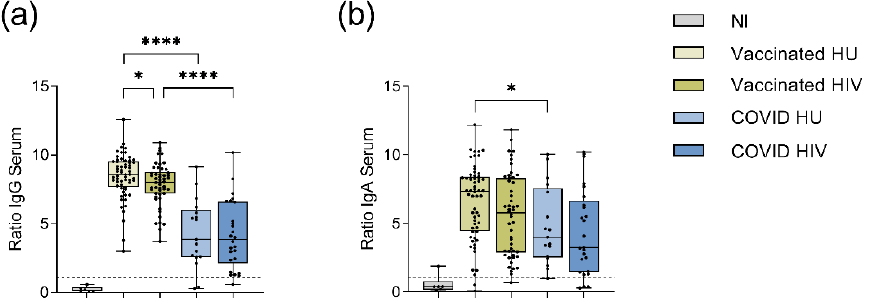
Figure 1. Spike-specific IgG and IgA antibodies in the serum of vaccinated and COVID-19 conva- lescent subjects as measured by ELISA. The IgG and IgA levels are presented as ratios obtained by dividing the extinction of the sample by that of the assay calibrator. ( a ) Spike-specific IgG and ( b ) Spike-specific IgA in the serum of BNT162b2 mRNA vaccinated ( n = 110) and COVID-19 con- valescent ( n = 43) subjects. Medians and interquartile ranges (IQRs) are presented for SARS-CoV-2 non-immune (NI, n = 6), vaccinated HIV-1-uninfected (HU, n = 60), vaccinated HIV-1-infected (HIV, n = 50), COVID-19 convalescent HIV-1-uninfected (COVID HU, n = 17) and COVID-19 convalescent HIV-1-infected (COVID HIV, n = 26). All BNT162b2 mRNA vaccinated and COVID-19 convalescent subjects had significantly higher IgG- ( p ≤ 0.0001) and IgA-ratios ( p ≤ 0.001) compared to the NI group ( p not indicated in the graph). Significance was tested by Mann–Whitney-U test. * = p ≤ 0.05, **** = p ≤ 0.0001. Exact p values are shown in Supplementary Table S2. The cut-off ratio for a positive result at ≥1.1 is indicated by dashed lines.